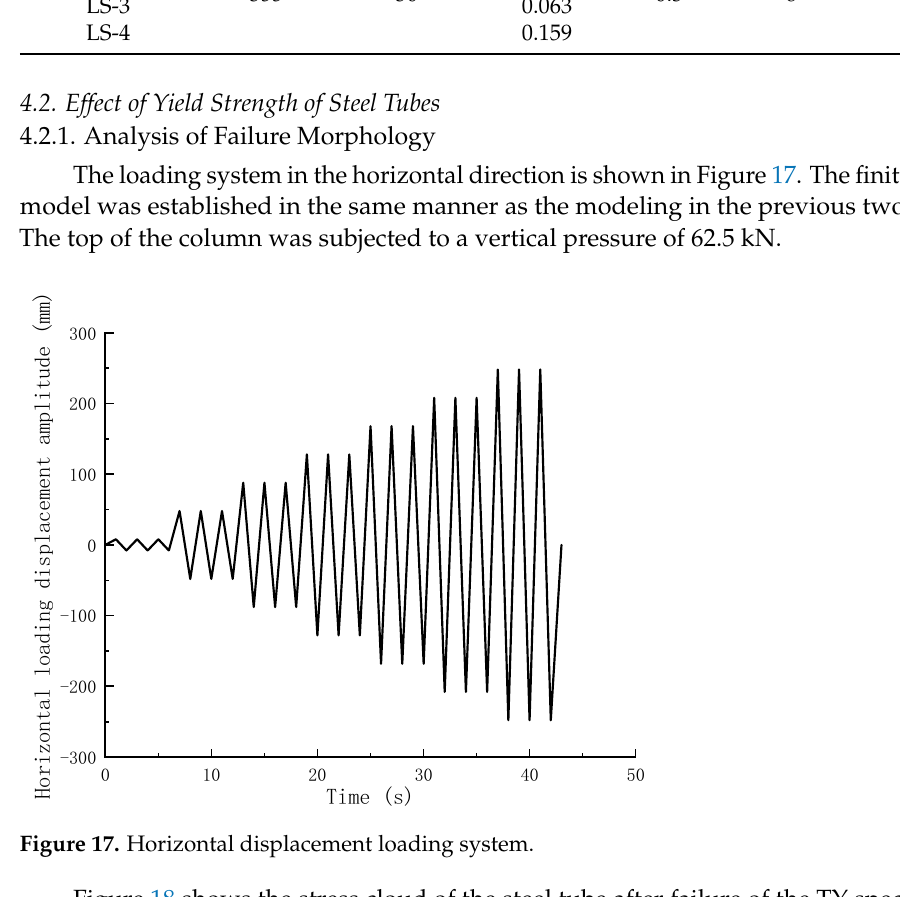
Table 12. Specific settings of the variable parameters of the USCFST-LCCFSE column connection components.